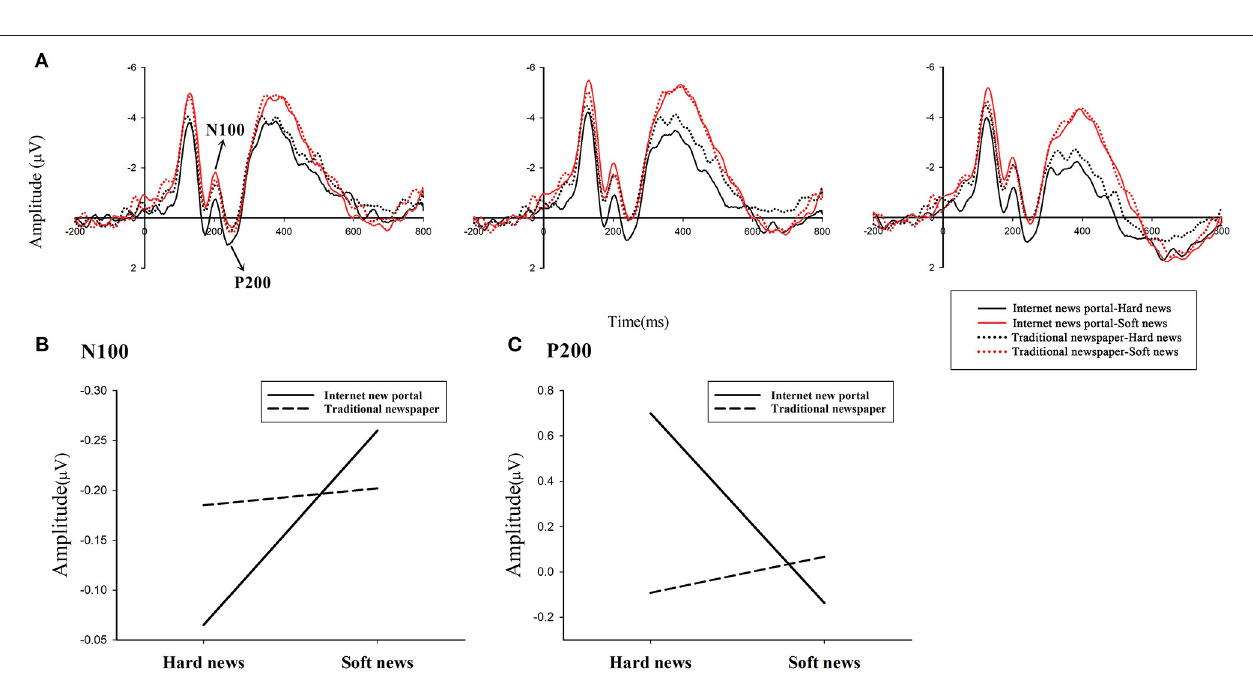
FIGURE 4 | Grand-average N100 and P200 ERP waveforms elicited by news headlines in the three electrodes (Fz, FCz, and Cz): (A) the comparison of different media channels presenting different types of news. (B) Interaction effect between media channel and news type on N100. (C) Interaction effect between media channel and news type on